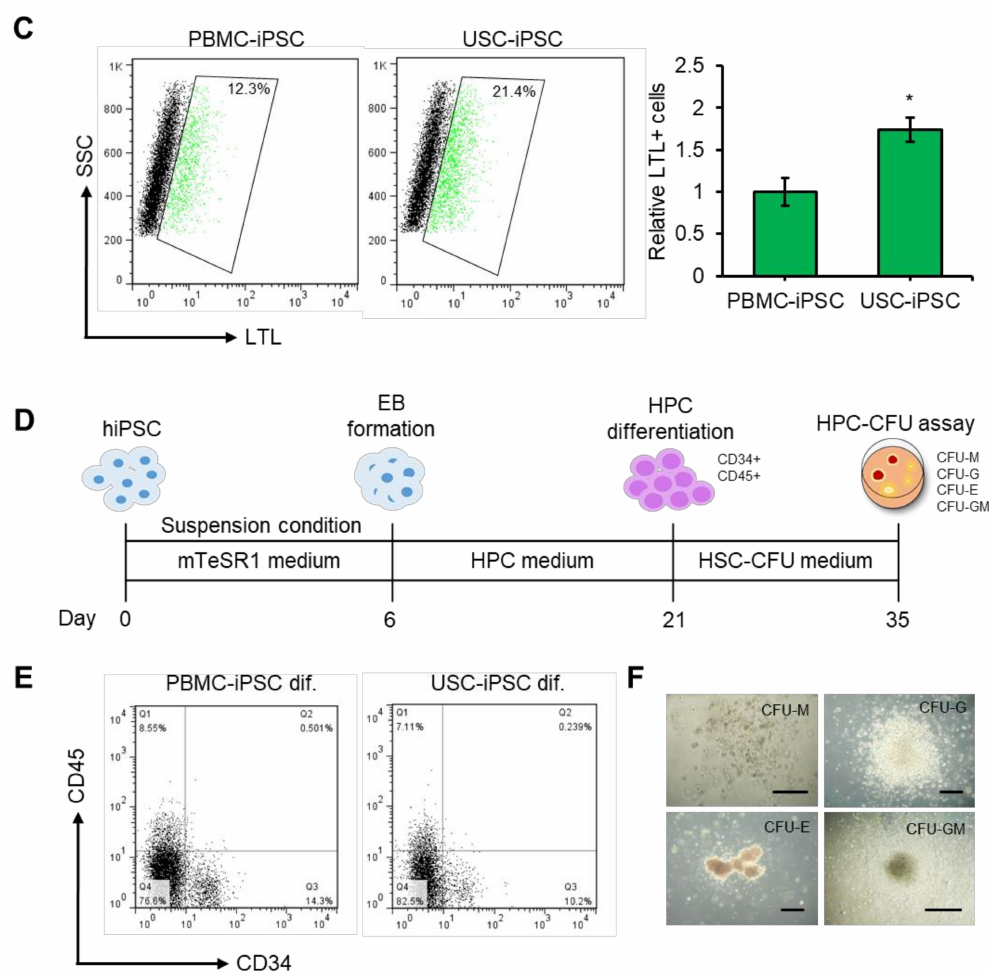
Figure 7. Di ff erentiation of USC-iPSCs. ( A ) Schematic representation of USC-hiPSC-derived kidney organoids. ( B ) Representative images showing changes in cell morphology and lotus tetragonolobus lectin (LTL) proximal tubule marker expression during 16 days of kidney organoid di ff erentiation. Scale bar: 100 µ m. ( C ) Flow cytometry analysis of LTL binding in PBMC-iPSC and USC-iPSC derived kidney organoids as a percentage of the total population. The data are presented as fold changes compared with the PBMC-iPSC. ( D ) Schematic representation of USC-iPSC derived HPCs. ( E ) Flow cytometry analysis of HPC markers of di ff erentiated USC-iPSC derived HPCs. ( F ) Colony forming unit (CFU) analysis of USC-hiPSC derived HPCs. M, Megakaryocyte; G, Granulocyte; E, Erythroid. n = 3 biological samples. (* p <